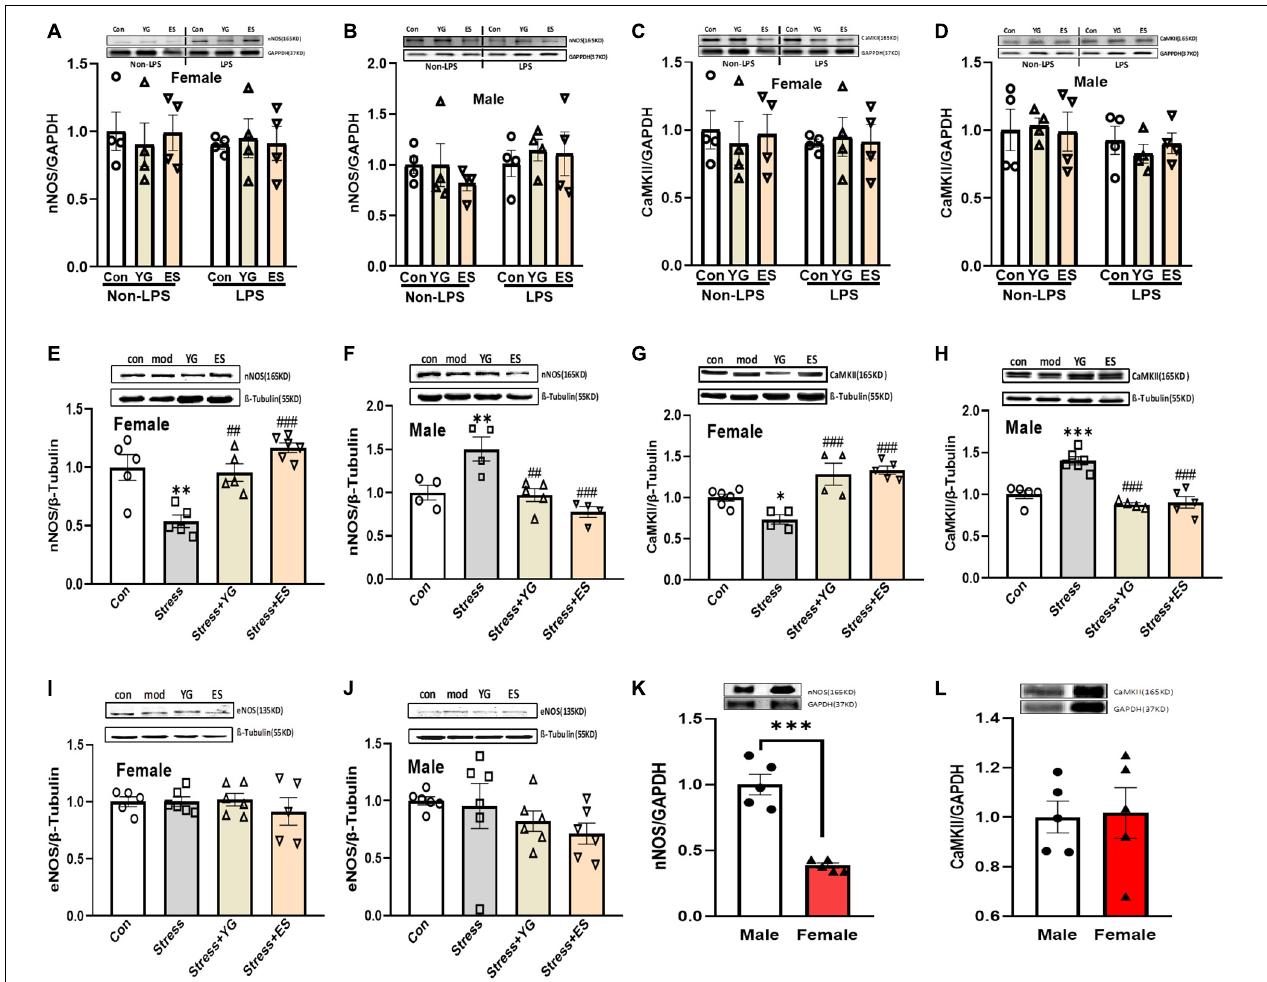
FIGURE 5 | CaMKII, nNOS, and eNOS expression in the hippocampus after chronic administration of stress, YG and ES in female and male mice. (A) nNOS expression in female mice in non-LPS or LPS treatment. (B) nNOS expression in male mice in non-LPS or LPS treatment. (C) CaMKII expression in female mice in non-LPS or LPS treatment. (D) CaMKII expression in male mice in non-LPS or LPS treatment. (E) nNOS expression in female mice after CUS or drug treatment. (F) nNOS expression in male mice after CUS or drug treatment. (G) CaMKII expression in female mice after CUS or drug treatment. (H) CaMKII expression in male mice after CUS or drug treatment. (I) eNOS expression in female mice after CUS or drug treatment. (J) eNOS expression in male mice after CUS or drug treatment. (K) nNOS expression in normal female and male mice. (L) CaMKII expression in normal female and male mice. ∗ p < 0.05, ∗∗ p < 0.01, ∗∗∗ p < 0.001 compared with the control group; ## p < 0.01, ### p < 0.001, compared with the CUS group, one-way ANOVA or two-way ANOVA, n =